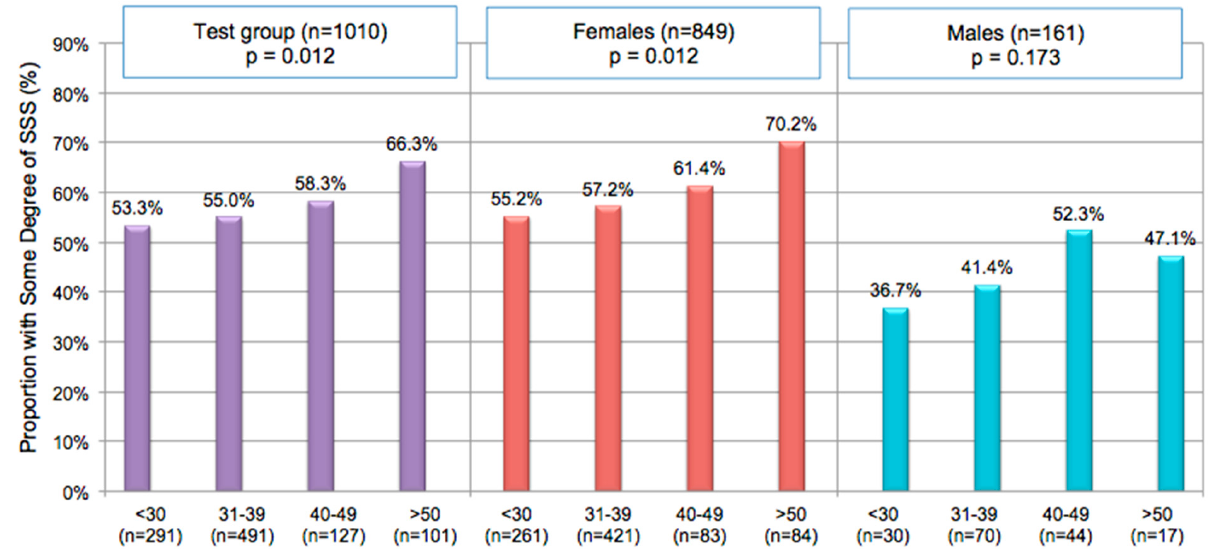
Figure 1. Age and Gender Effect on Prevalence of Sensitive Genital Skin. Responders were asked if they had sensitive skin (“slight”, “moderate” or “very”) [35,36]. MH Chi-Square was used to test for correlations between perceptions of sensitive skin and age for responders overall and for each gender. Adapted from [37].